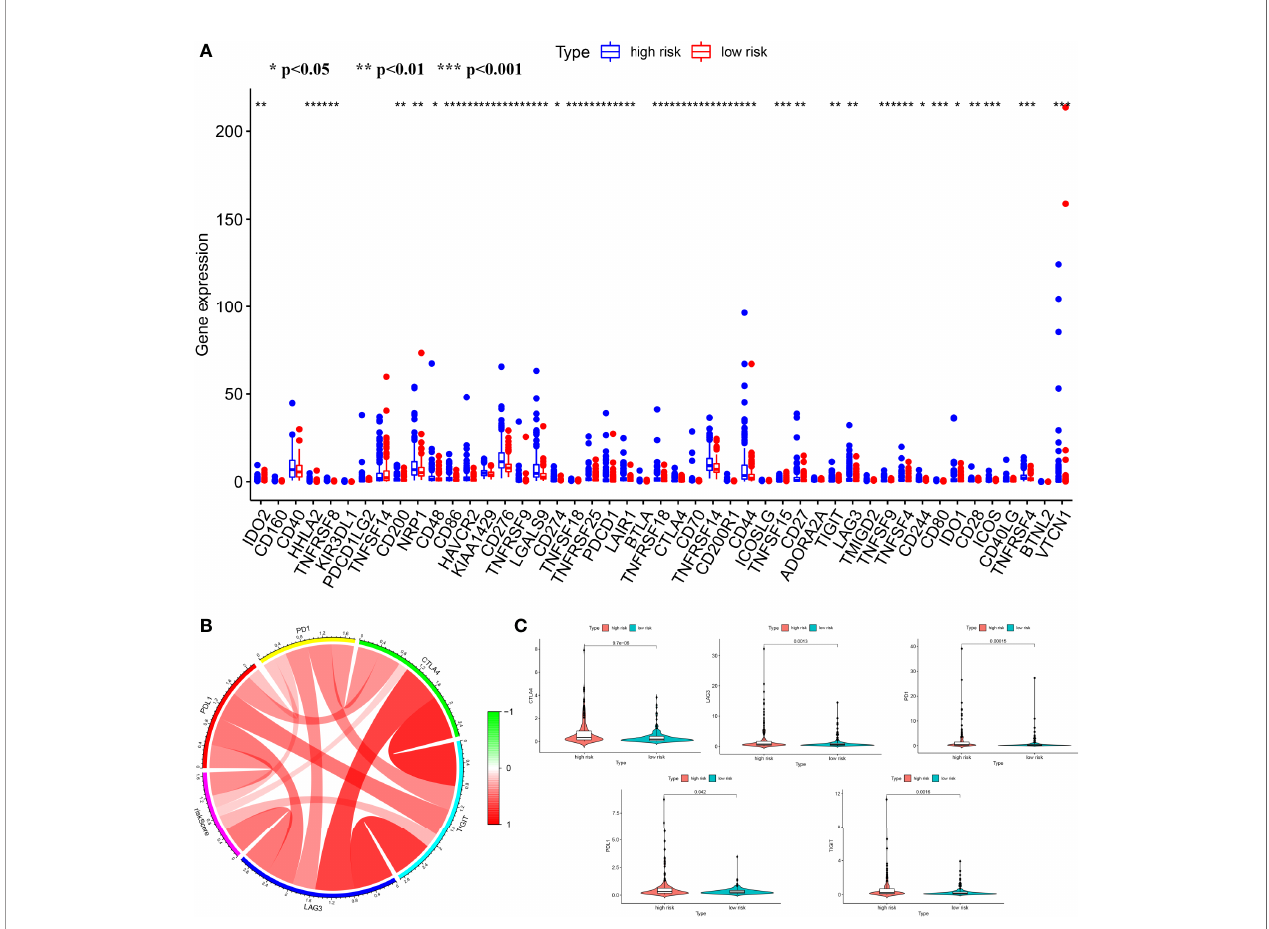
FIGURE 8 | The differences of the expression level of immune checkpoint between high- and low risk groups (A) The boxplot of the expression level of immune checkpoint between high- and low risk groups (B) The correlation analysis between the risk score and the expression levels of PD1, PDL1, TIGIT, CTLA4 and LAG3 (B, C) The Comparison of the expression level of PD1, PDL1, TIGIT, CTLA4 and LAG3 between high- and low risk groups. ***p < 0.001; **p < 0.01; *p <